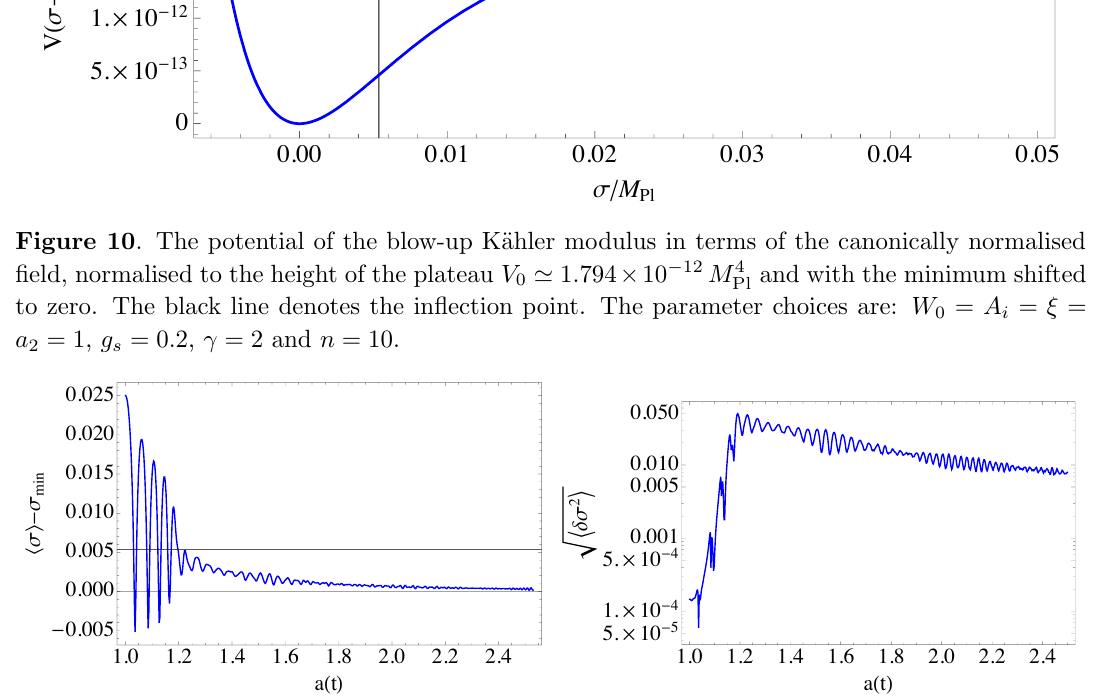
Figure 11 . Top: evolution of the mean of the blow-up modulus h (cid:27) i as a function of the scale factor a ( t ). The solid black line denotes the (cid:12)eld value at the in(cid:13)ection point of the potential. One can see that the initially homogeneous (cid:12)eld decays into inhomogeneous (cid:13)uctuations within four oscillation. Bottom: evolution of the variance h (cid:14)(cid:27) 2 i 1 = 2 . The evolution becomes non-linear when h (cid:14)(cid:27) 2 i 1 = 2 becomes comparable to the amplitude of oscillation of homogeneous component h (cid:30) i .